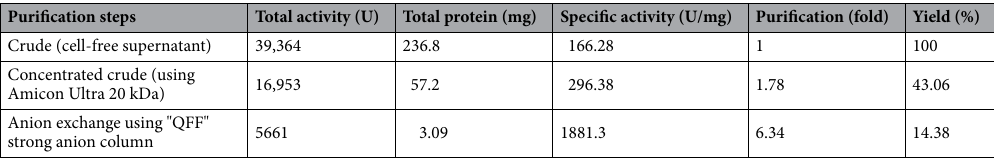
Table 4. Purification scheme of the protease/keratinase enzyme produced by Laceyella sacchari strain YNDH.